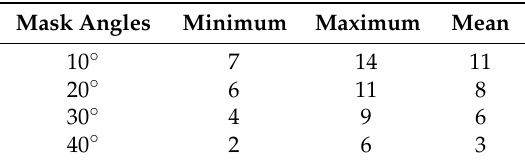
Table 1. GPS satellite visibility for different mask